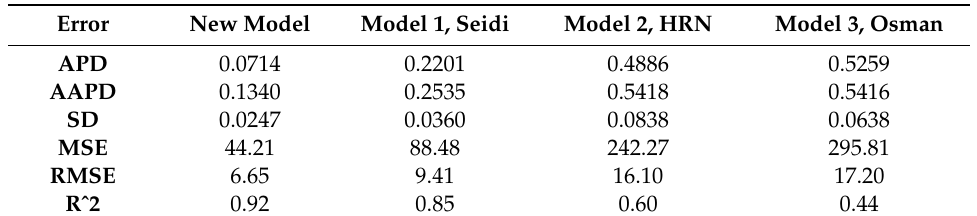
Figure 3 . Estimated gas flow rate versus real gas flow rate (validation) .